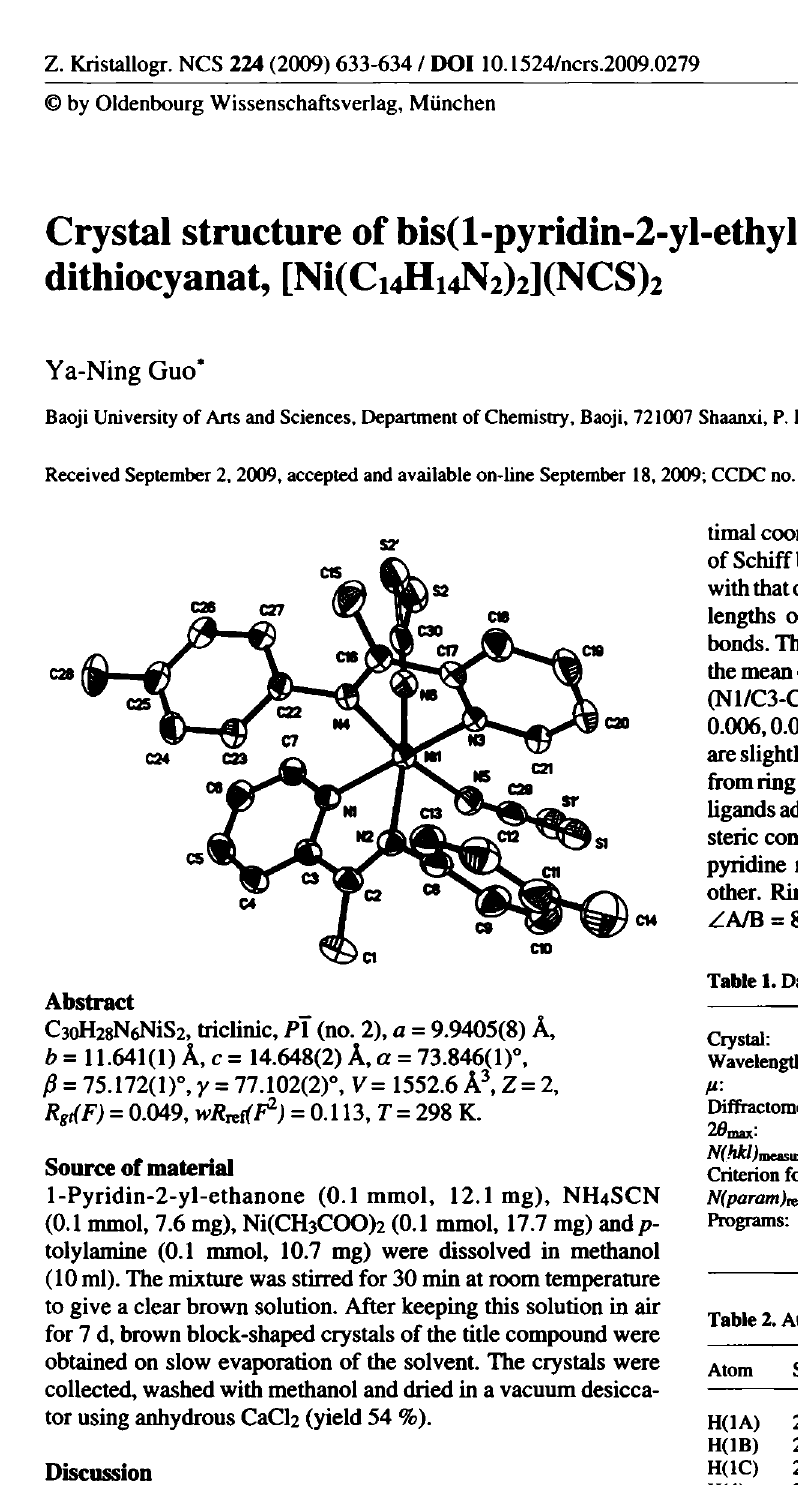
Table 2. Atomic coordinates and displacement parameters (in Â 2